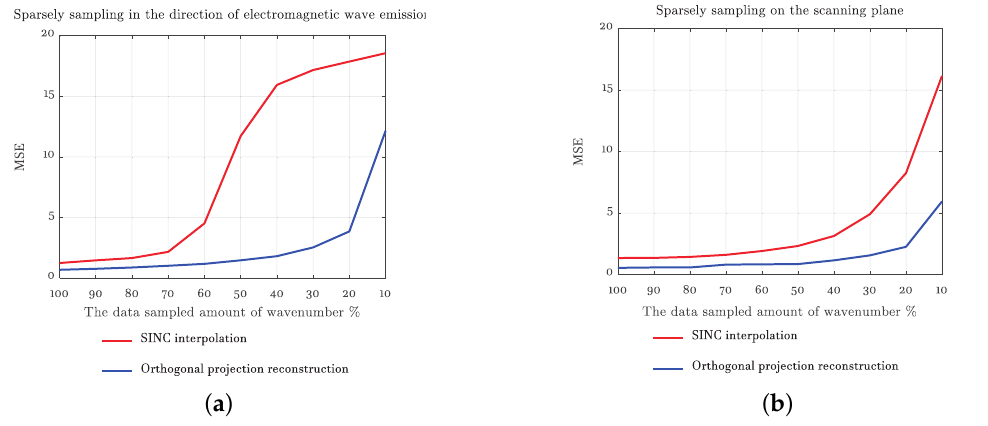
Figure 6. Wave spectrum transformation mean square error curves. ( a ) Sparsely sampling in the direction of electromagnetic wave emission. ( b ) Sparsely sampling on the scanning plane.